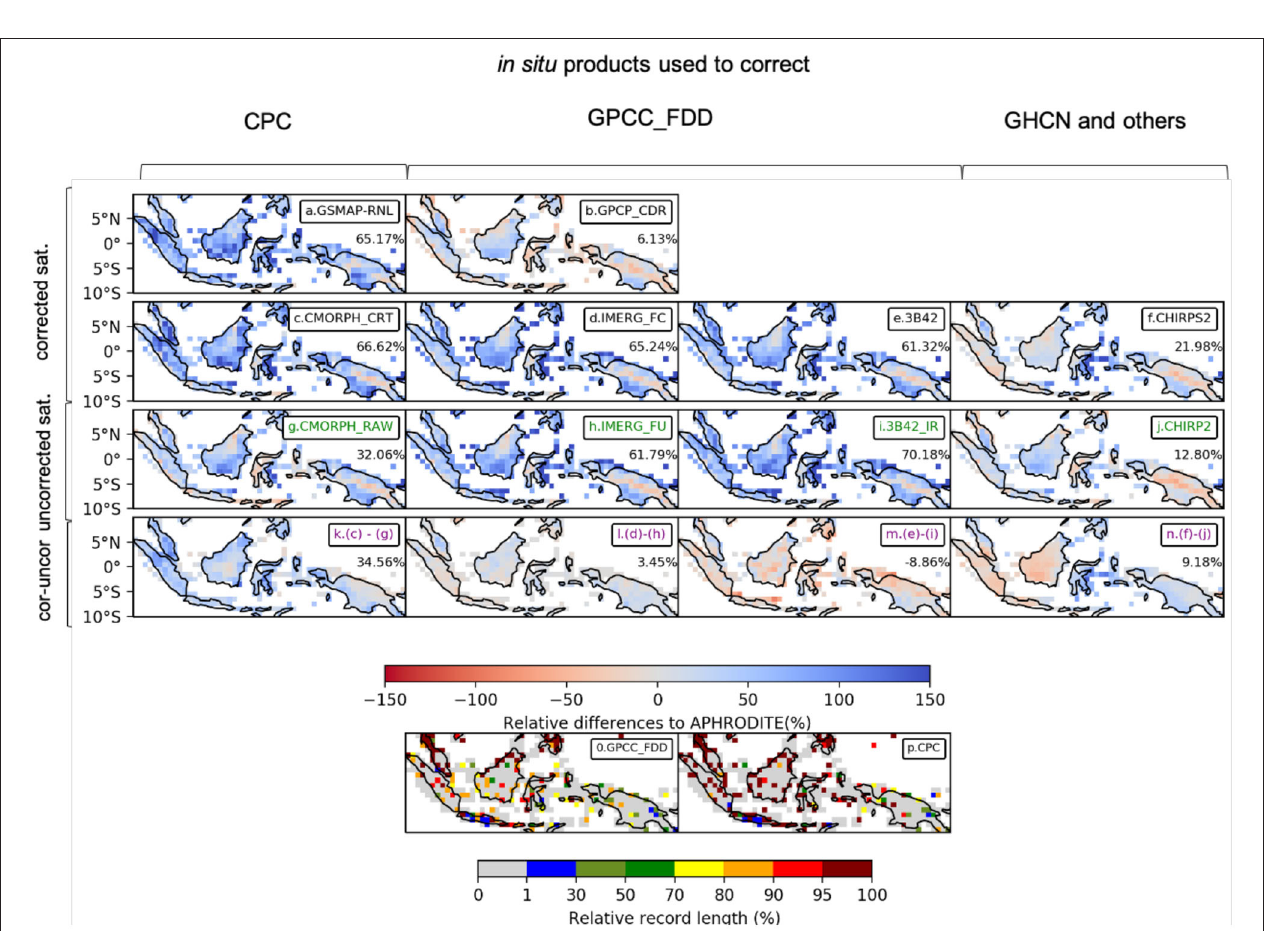
FIGURE 6 | CHIRPS2; uncorrected satellite products (green label, the third row): (g) CMORPH_RAW, (h) IMERG_FU, (i) 3B42_IR, (j) CHIRP2; and the differences between the corrected and uncorrected products (k–n) . The number inserted on each panel indicates the regional average of these relative differences. The in situ products that satellite products used to correct are also mentioned at the top of the figure. The last two panels also show the percentage of data available for each grid cell during the 2001–2013 period in these in situ -based datasets [ (o) GPCC_FDD, (p) CPC] used for correction of satellite products.